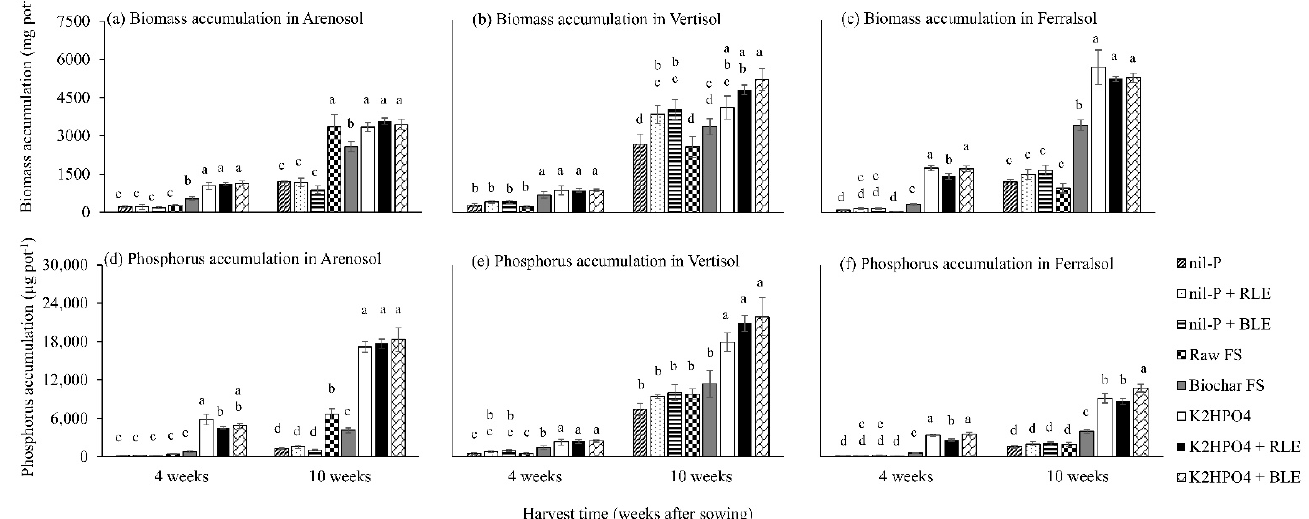
Figure 2. Accumulation of ryegrass biomass in the Arenosol ( a ), Vertisol ( b ) and Ferralsol ( c ), and phosphorus in the Arenosol ( d ), Vertisol ( e ) and Ferralsol ( f ) at 4 weeks and 10 weeks after sowing. Error bars depict SEM ( n = 4). Means at a given harvest (4 weeks or 10 weeks) that are not followed by a common letter are significantly different at p < 0.05.